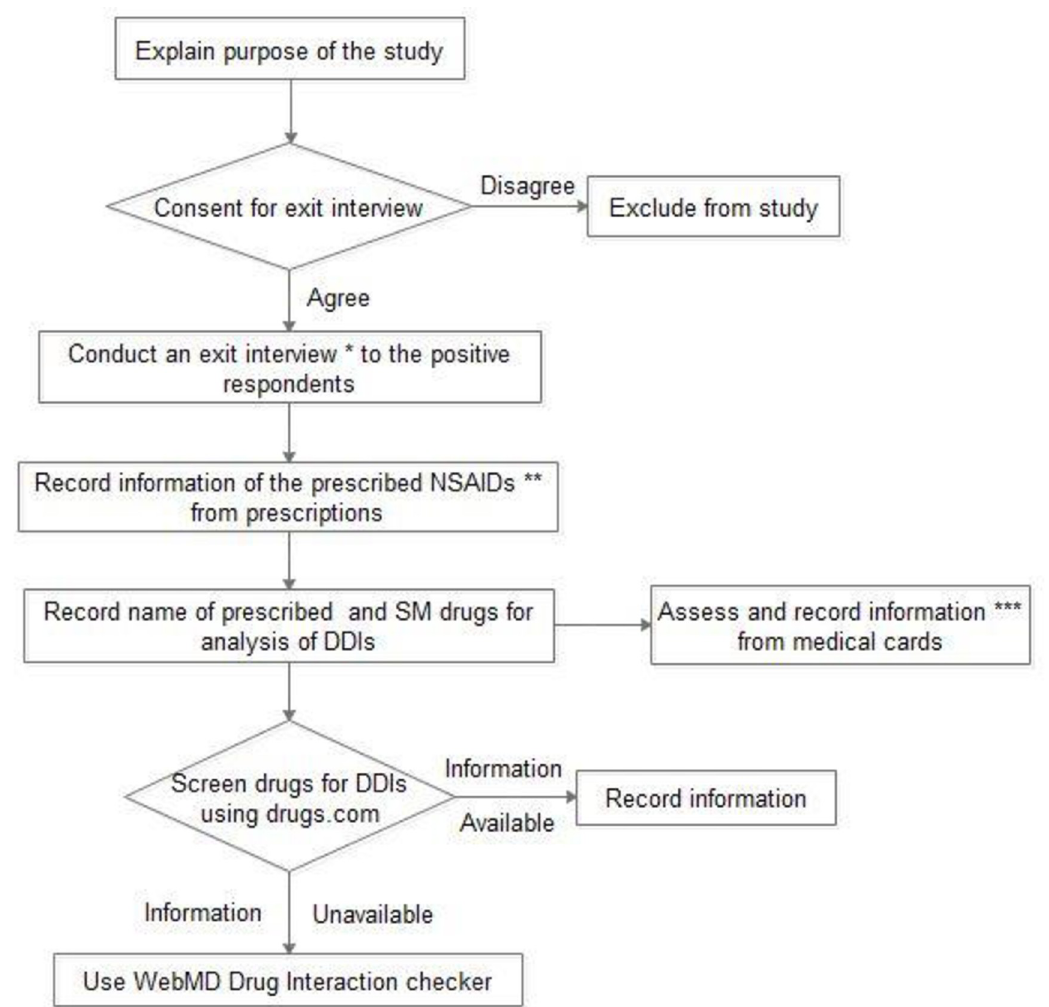
Fig 1. Data collection procedure. Exit interview � aimed at exploring socio-demographic and background characteristics, usage of gastro-protective agents among chronic NSAID users, ADRs encountered and self-medication status of the participants. Information of the prescribed NSAIDs �� includes dose, frequency, duration of treatment, route of administration and dosage form. Information from medical cards ��� includes indications of the prescribed NSAID(s), comorbidity and history of peptic ulcer. NSAIDs : Non-steroidal Anti-Inflammatory Drugs; SM drugs: Self-Medicated drugs; DDIs : Drug-drug